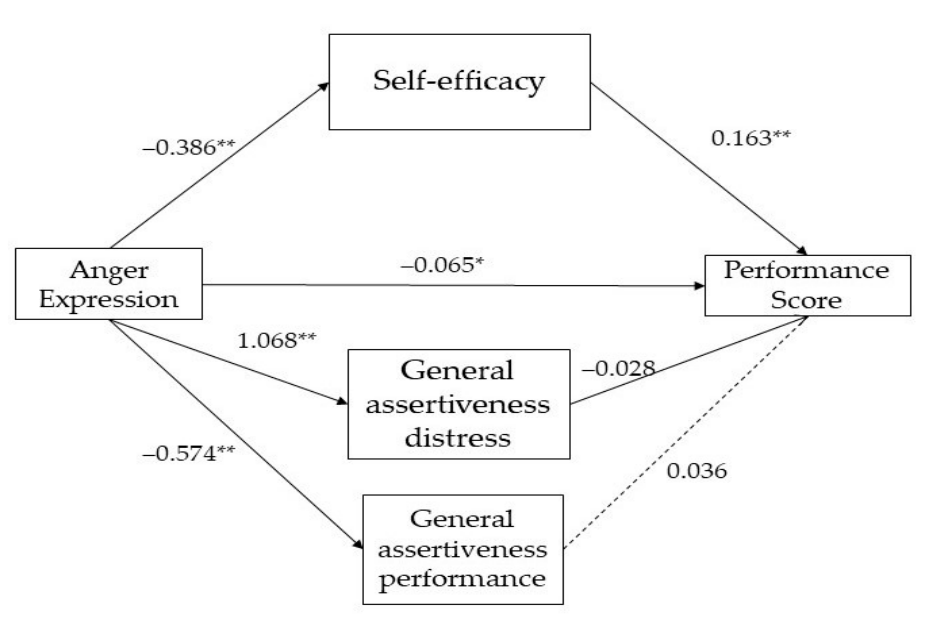
Figure 1. Parallel-multiple mediation of self-efficacy and general assertiveness (distress and per- formance) between anger expression and performance children’s score (group of parents). Note: * p < 0.01; ** p < 0.001. Dashed lines indicate non-significant effects.